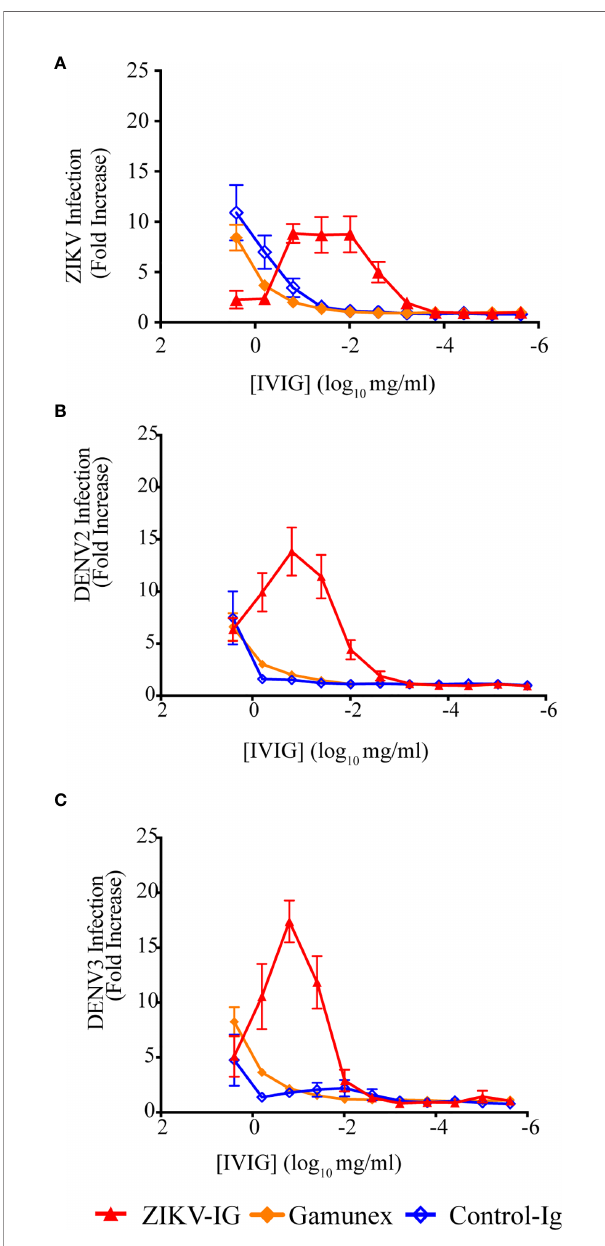
FIGURE 2 | ZIKV-IG in vitro enhancement of ZIKV and DENV serotypes 2 and 3. The ability of three IVIG products, ZIKV-IG, Control-IG, and Gamunex ® to enhance (A) ZIKV, (B) DENV2 and (C) DENV3 infection in K562 cells. For antibody enhancement serial dilutions of IVIG were incubated with a constant amount of virus then added to K562 Fc expressing cells. Then infected cells were enumerated by fl ow cytometry. The base line infection of K562 cells was 2.43% +/- 1.44 for ZIKV, 3.78% ± 2.26% for DENV2 and 2.12% ± 1.09% for DENV3. Fold enhancement data is shown as single points that represent the mean of 3-4 independent experiments completed in duplicate +/-